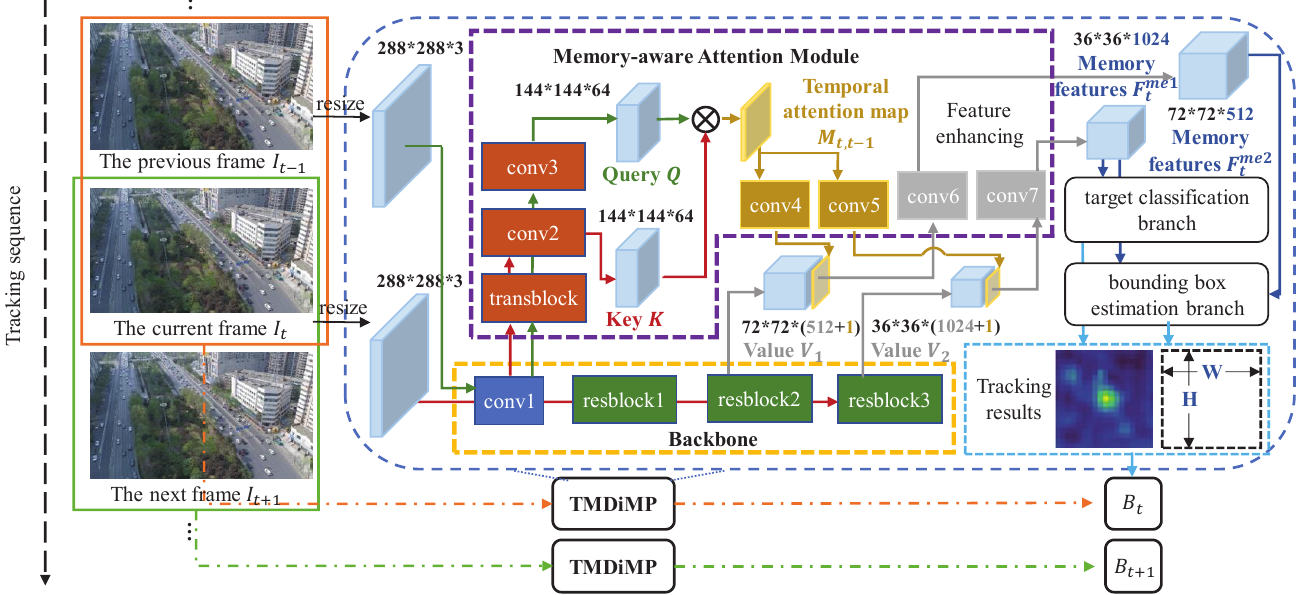
Figure 1. The framework of our proposed